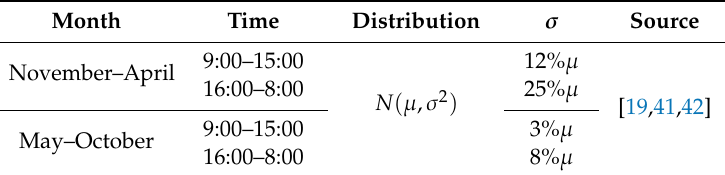
Table A4. The probability distribution of solar radiation.